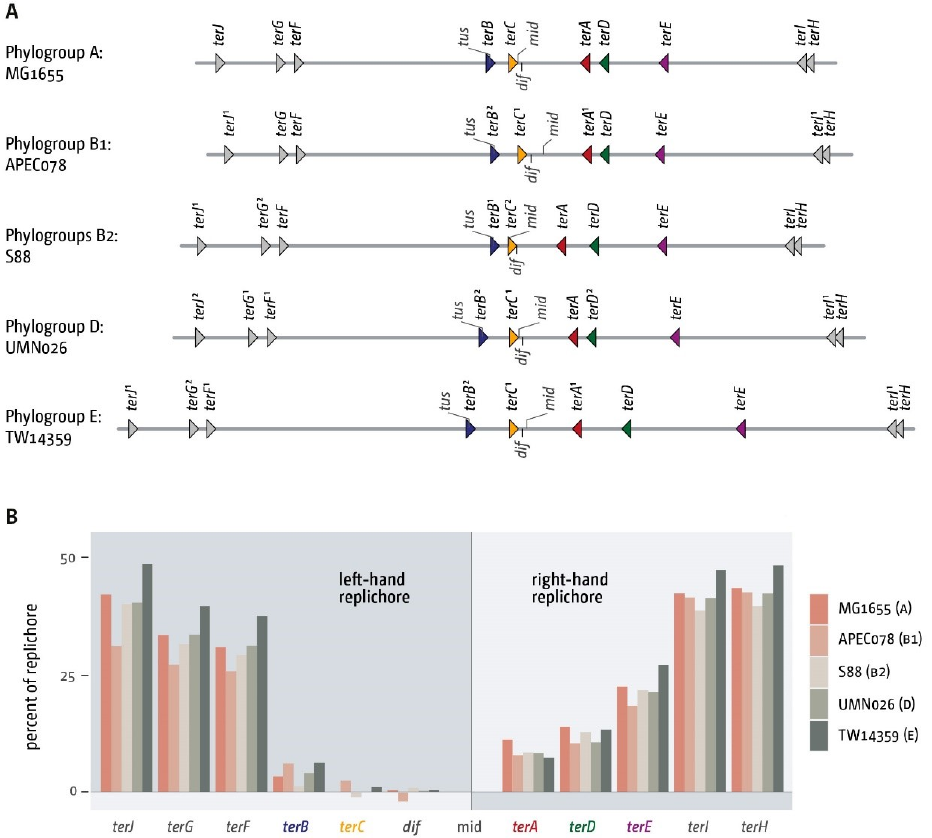
Figure 2. Architecture of the replication fork trap in genomes from the five E. coli genomes representing the phylogroups A, B1, B2, D and E. ( A ) Absolute positions of all primary ter sites in five E. coli genomes representing the phylogroups A, B1, B2, D and E. All ter sites are identified by triangles. The chromosome dimer resolution site dif is indicated by a tick mark. Orientation of the ter sites is indicated by triangle orientation. Forks meeting the tip of the triangle first will be blocked. If single nucleotide changes occur in comparison to the MG1655 reference genome, the number of changes is shown in superscript. The strand location of dif is indicated by the direction of the marker. The marker pointing downwards indicates that the dif sequence as defined in [48] is on the ( − )-strand. ( B ) Comparative analysis of the relative positions of ter sites within the chromosomal context in five E. coli genomes representing the phylogroups A, B1, B2, D and E. To compensate for the different genome sizes the theoretical midpoint of each genome was calculated and used as basis for the analysis. The distance of all ter sites, as well as the chromosome dimer resolution site dif , were calculated as percent of the replichore (so oriC would be 100%). This gives an indication of how much the relative position of these elements varies between the genomes. Phylogroups are indicated in brackets after the strain